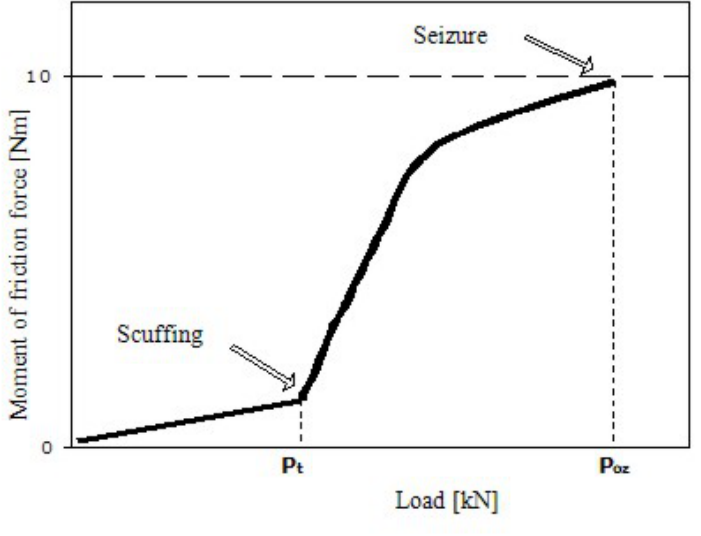
) as a function of load (P) T